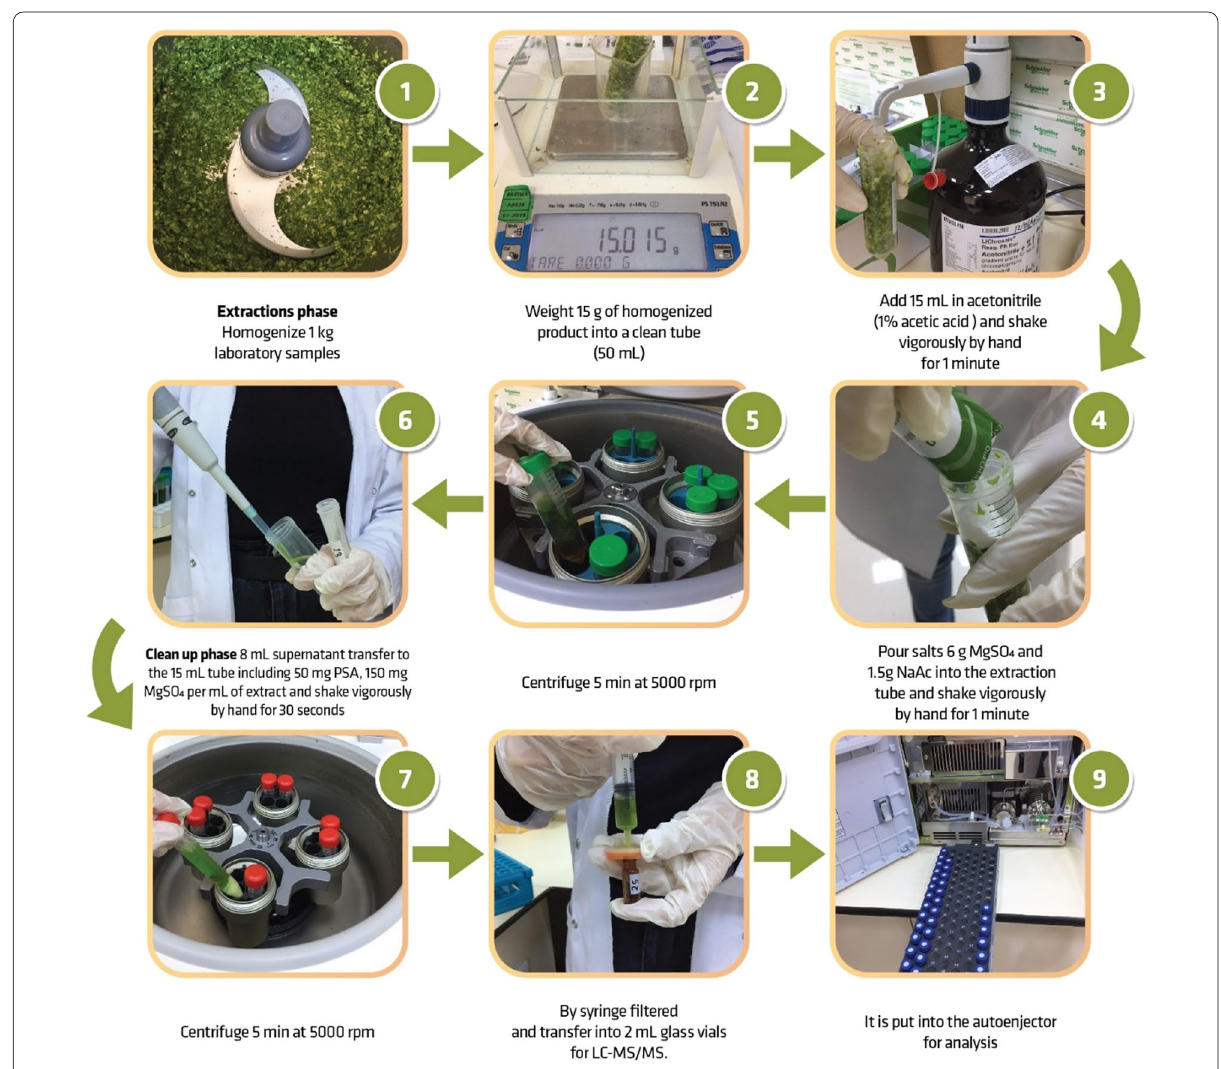
Fig. 1 AOAC Official Method 2007.01 sample preparation